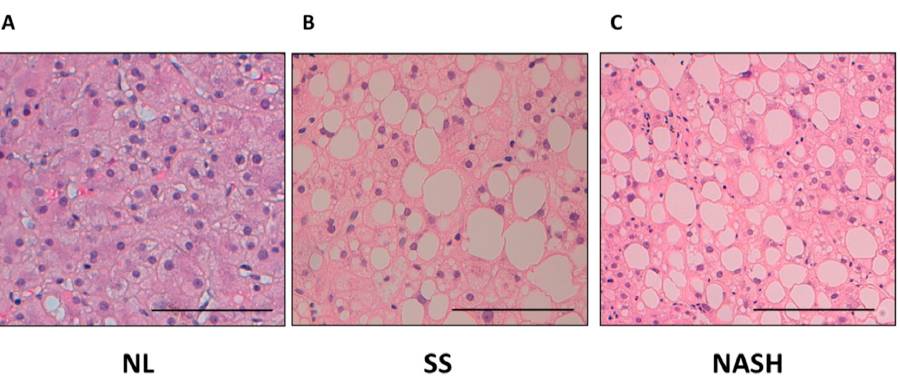
Figure 6. Histological images of liver biopsies stained with eosin-hematoxylin from ( A ) women with MO with NL histology ( B ) women with MO with SS, and ( C ) women with MO with NASH. X400, scale bar: 100 μ m.